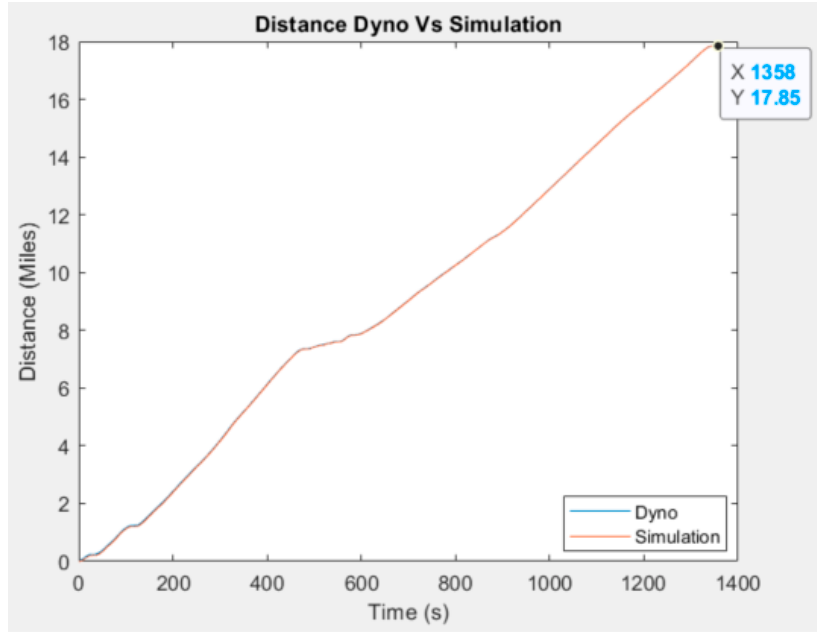
Figure 23. Vehicle distance covered over